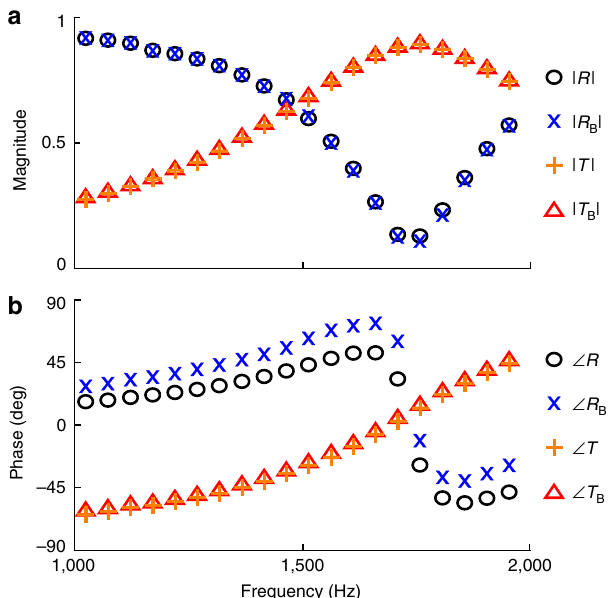
Figure 7 | Scattering coefficients measured in the plane wave impedance tube. The scattering coefficients for the forward orientation, R and T , and for the backward orientation, R B and T B , of the metamaterial sample. The magnitude and phase of the coefficients are shown in a , b , respectively. It is noteworthy that the sample is reciprocal and therefore the transmission coefficient T does not change with sample orientation. In terms of the scattering coefficients, for this measurement the transmission coefficient T ¼ T B . However, the phase of the reflection coefficients, R and R B , are shown to be dependent on sample